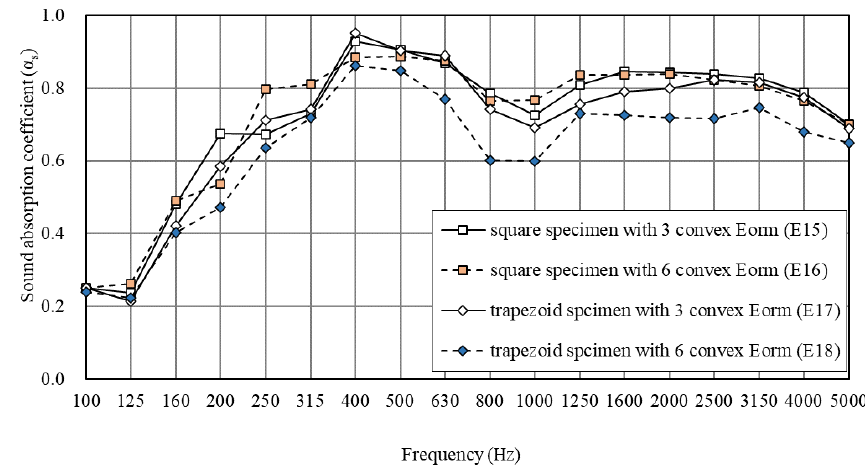
Figure 12. The sound-absorption coefficient of 30 mm FEMM with a 200 mm cavity.